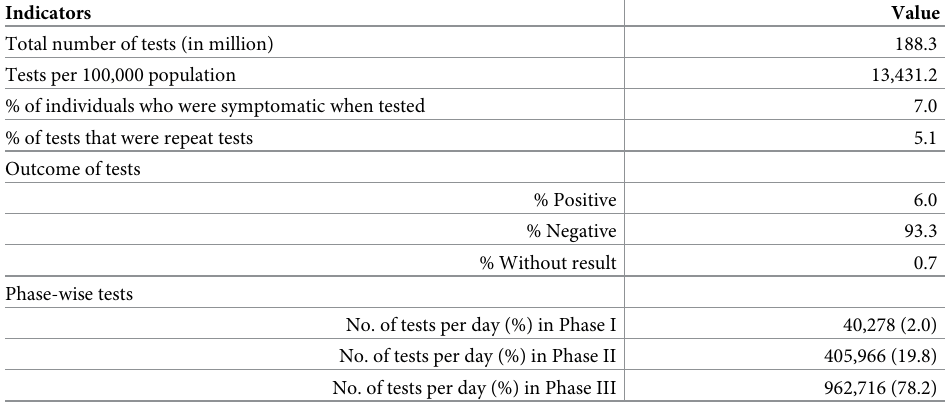
Table 2. Characteristics of the COVID-19 tests carried out in the laboratory surveillance network, India (March 2020 to January 2021).